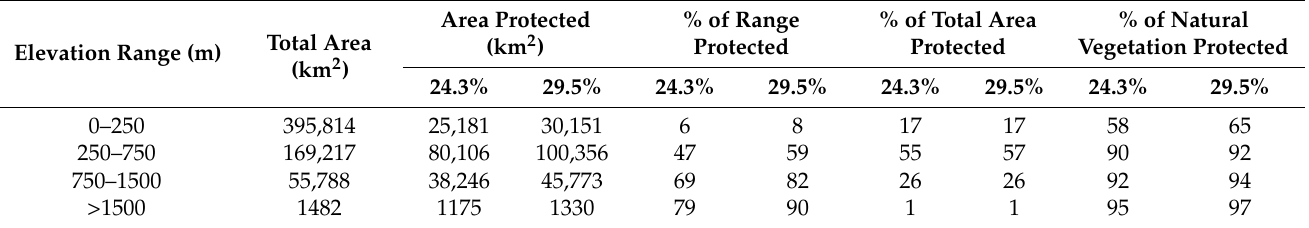
Table 3. Representation of elevational ranges in protected areas in Thailand currently (with 24.3% protected) and after expansion (with